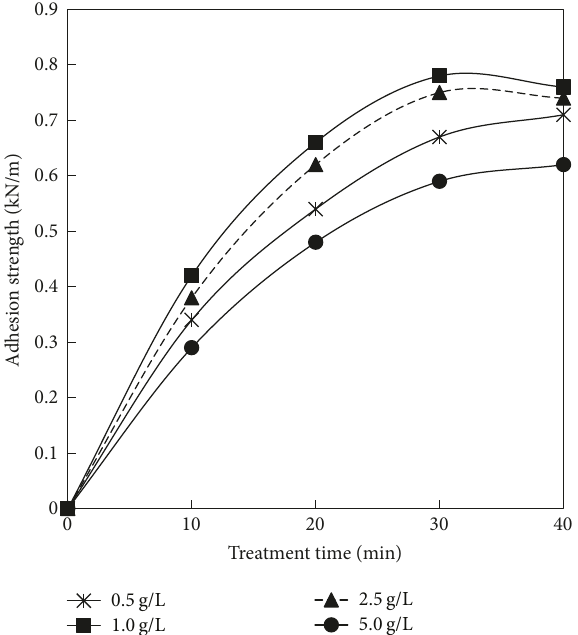
Figure 5: Dependence of the adhesion strength upon the TiO 2 content and the treatment time under 300 W UV